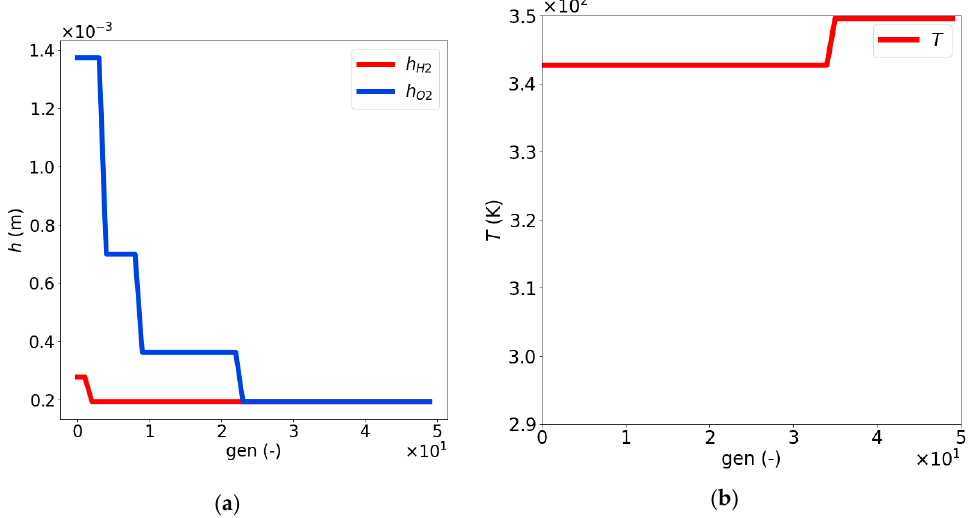
Figure 11. Design parameters evolution for the best DP set solution (in full DP space and for a single evolution) of the best candidate depending on the generation ( a ) for the anolyte and catholyte thickness h H 2 , h o 2 ( b ) for electrolyte temperature T